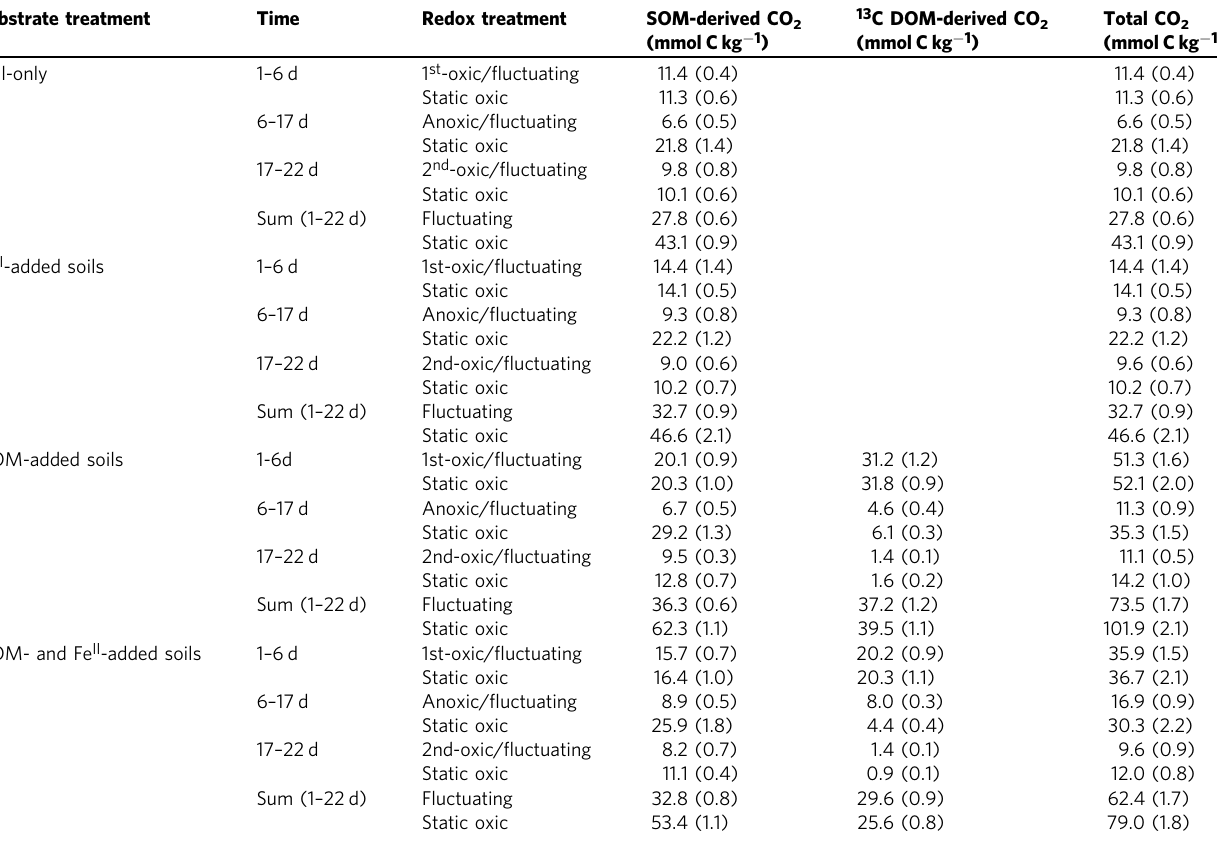
Table 2 Cumulative CO 2 production in the fl uctuating redox and static oxic treatments for all soils. Substrate treatment